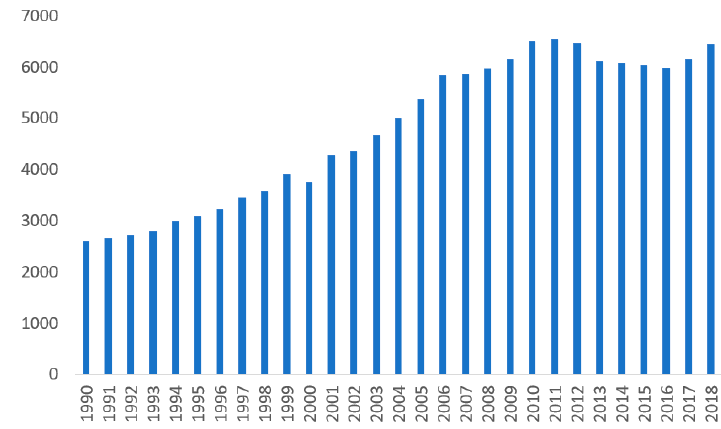
Figure 1. Final electricity consumption (thousand tonnes of oil equivalent, ktoe) [56].